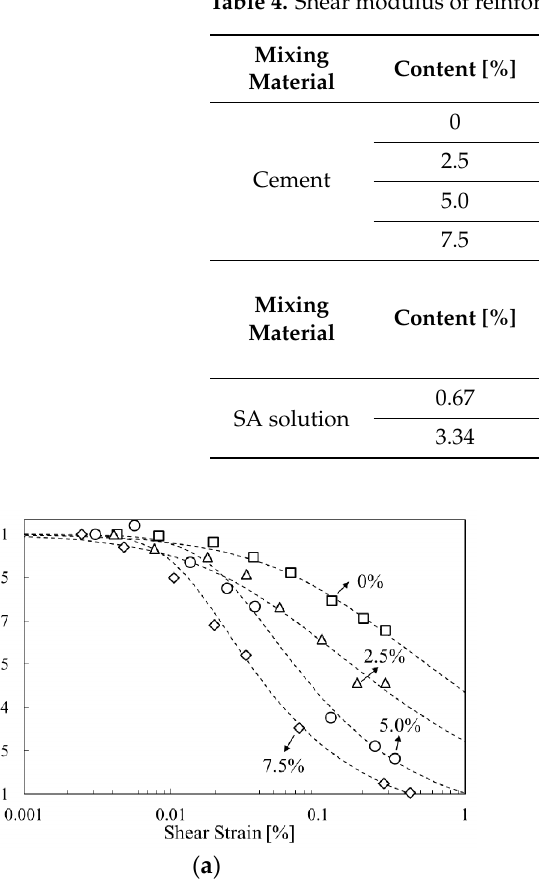
Figure 6. Variation of normalized shear modulus G/G max with shear strain: ( a ) reinforced soils with cement, ( b ) reinforced soils with sodium alginate (SA) solution.